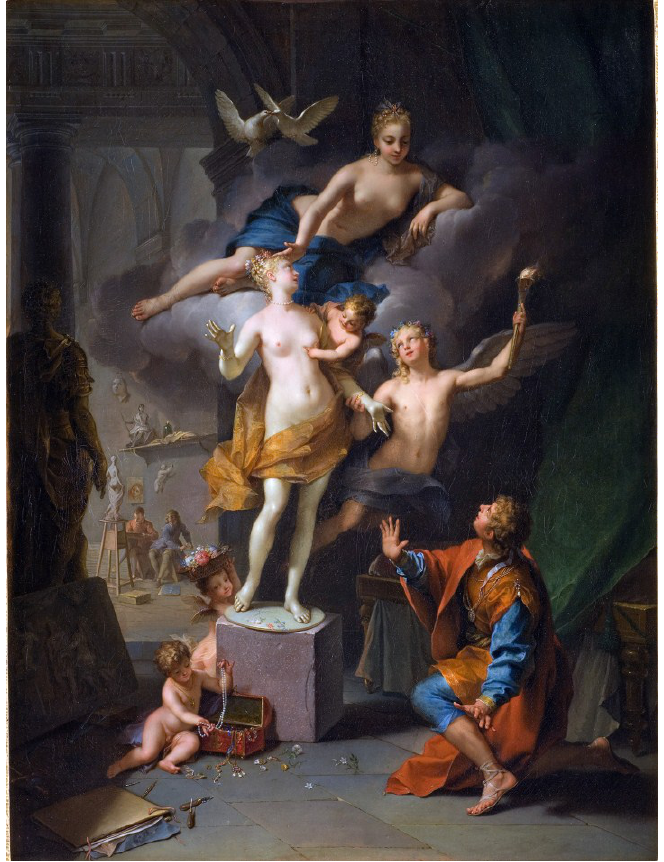
Figure 2. Raoux, Jean. Pygmalion Adoring His Statue . (Raoux 1717). Musée Fabre, Montpellier. Public domain.